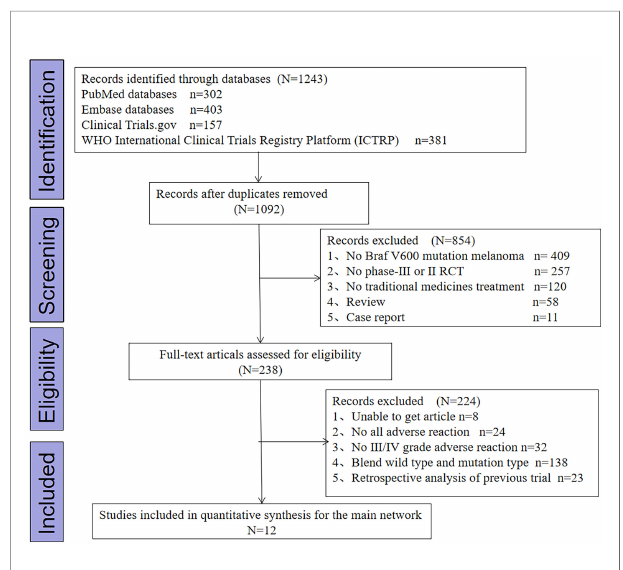
FIGURE 1 | Study selection